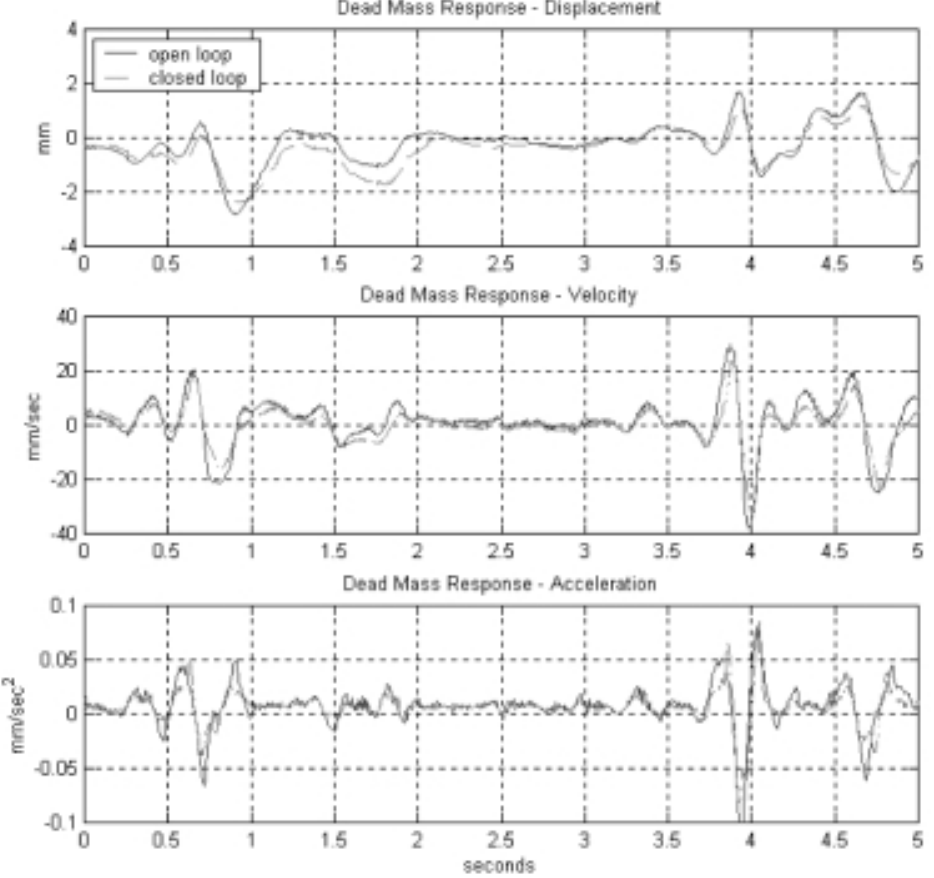
Fig. 14. Measured time history of the dead